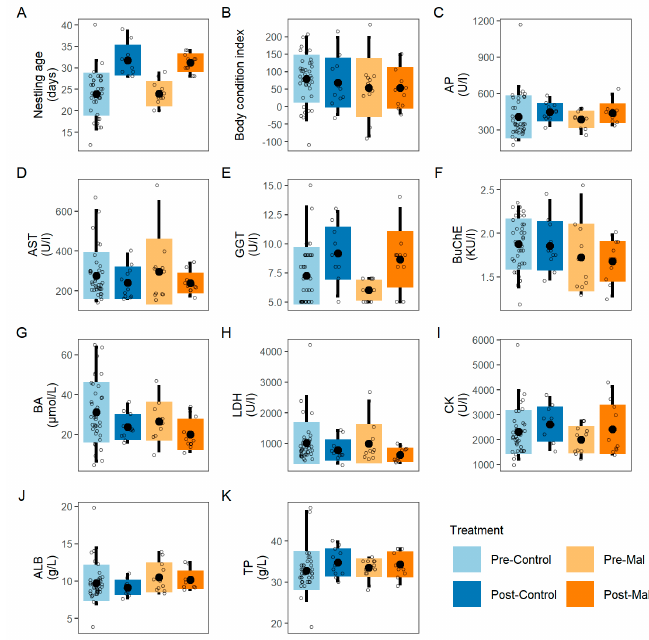
Figure 3. Mean differences of eleven parameters among treatment and control. Visualisation of mean differences in nestling age at sampling ( A ), body condition index ( B ), and blood chemistry parameters ( C − K ) among four groups: “Pre − Control”, “Post − Control”, “Pre − Mal”, and “Post − Mal”. Black dots represent mean estimates for each of the treatment groups. Main boxplots represent standard deviations, and error bars indicate 95% confidence intervals. Open circles represent raw data for each individual. See Table S2 for statistical comparisons of parameters ( B − K) .